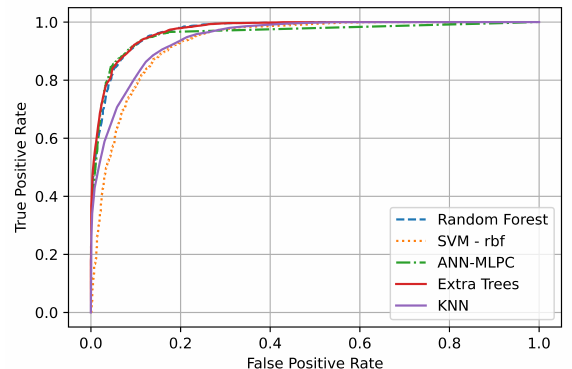
Figure 11. The receiver operating characteristic curve (ROC) of the top five ML models trained for attention classification using EEG data.